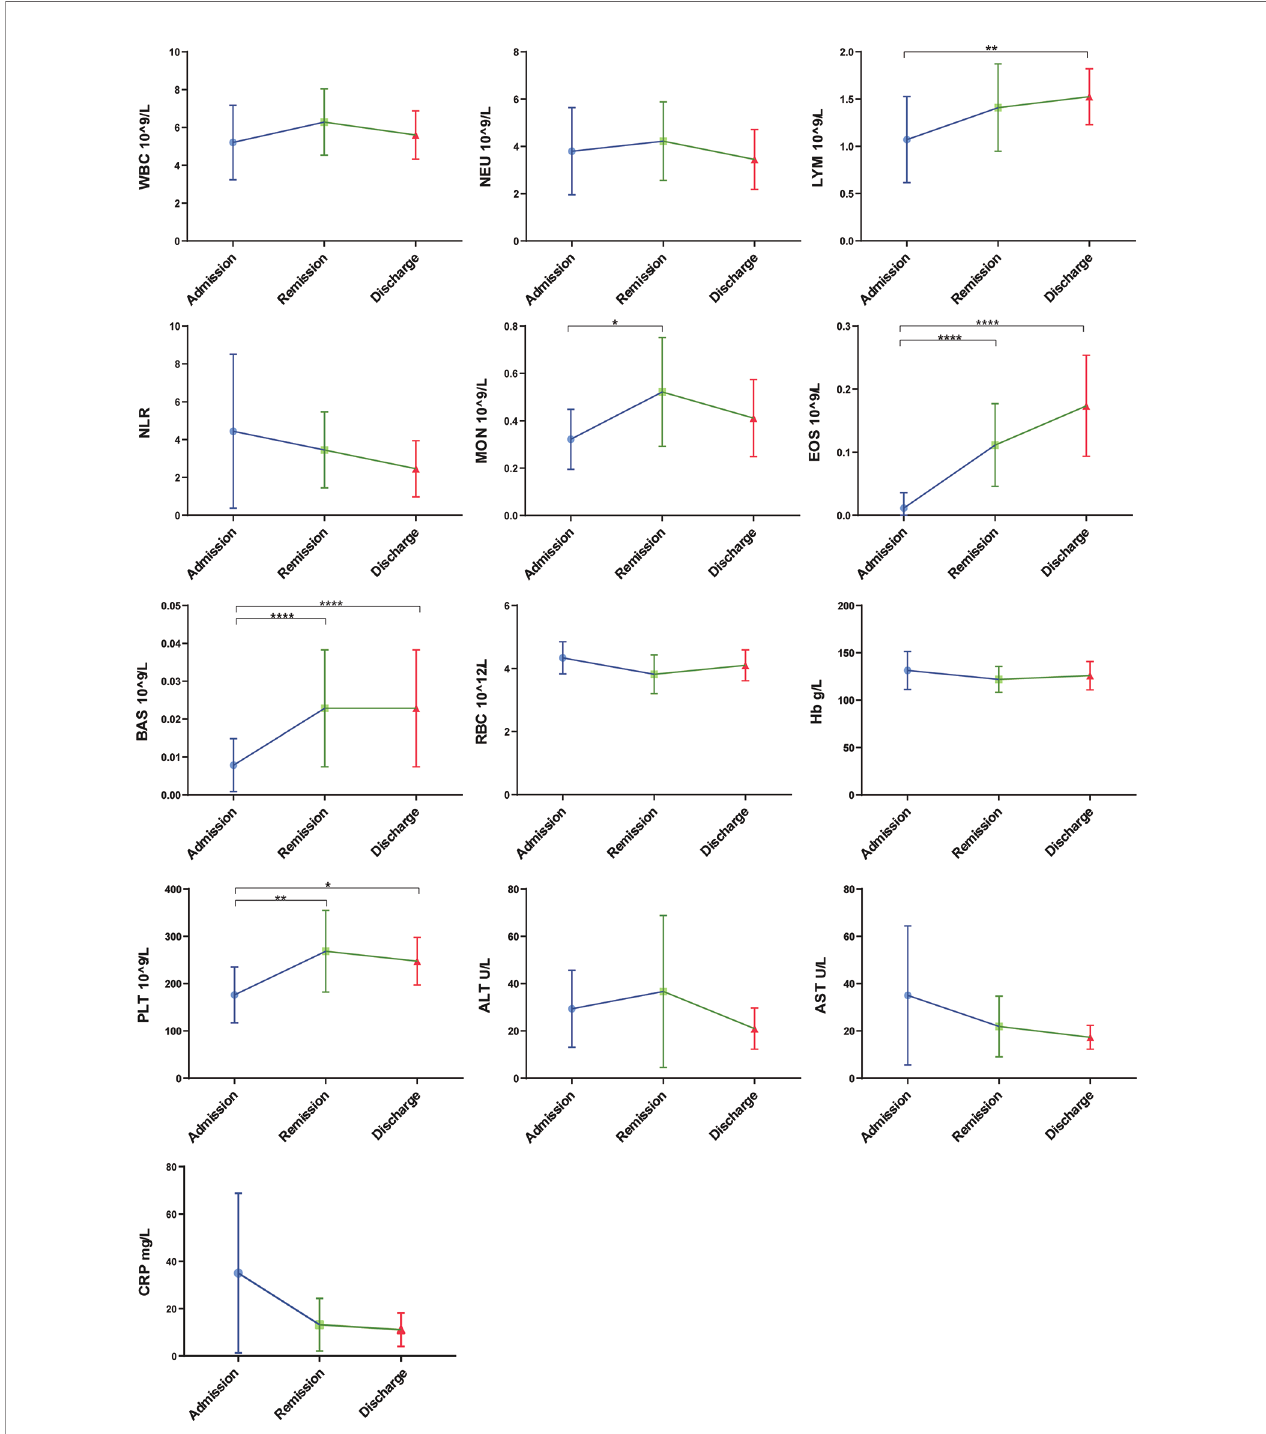
FIGURE 2 | Laboratory parameters with the progression of COVID-19/patient status (at three time points: admission, remission, and discharge). Different levels of routine complete blood count, hemoglobin (Hb), C-reaction protein (CRP) and liver function were found at different time-points of disease/patient status progression. Moreover, as patients improved, lymphocyte and eosinophil counts consistently increased, whereas NLR and AST consistently decreased. Admission group (n=14), remission group (n=14), discharge group (n=14). Signi fi cance is denoted as * P < 0.05, ** P < 0.01 and **** P < 0.0001. WBC, White blood cell count; NEU, Neutrophils count; LYM, Lymphocytes count; NLR, neutrophil-lymphocyte ratio; MON, Monocyte count; EOS, Eosinophil count; BAS, Basophils count; RBC, Erythrocyte count; Hb, Haemoglobin; PLT, Platelet count; ALT, Alanine aminotransferase; AST, Aspartate aminotransferase; CRP, C-reactive